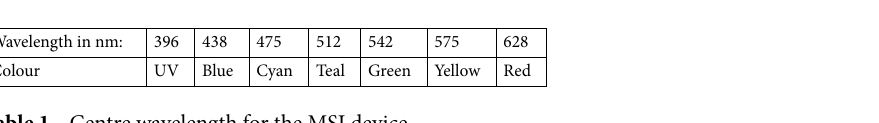
Table 1. Centre wavelength for the MSI